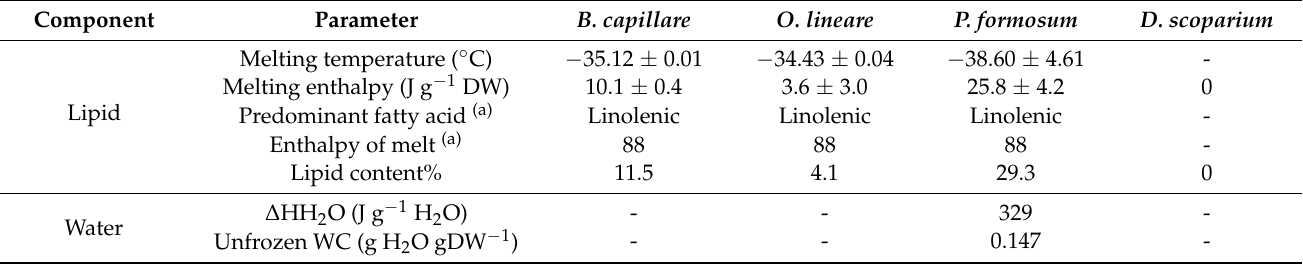
Table 2. Summary of the calorimetric properties measured for the bryophyte spores tested.